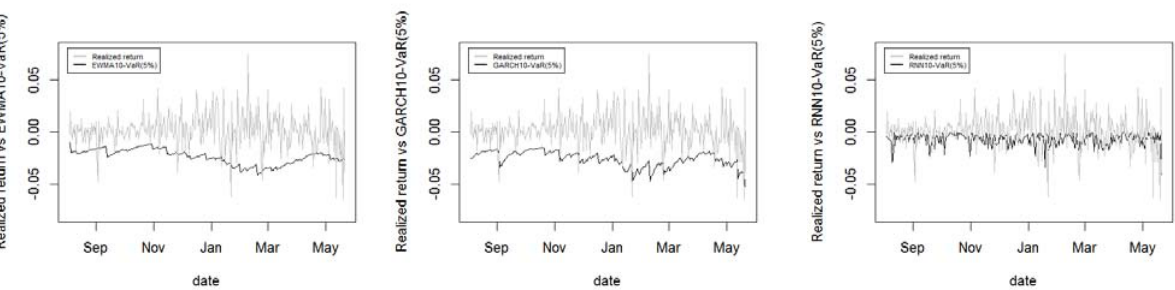
Figure A11. Out of sample realized return vs. 5 days ahead VaR (5%) of EWMA, GARCH and RNN model.